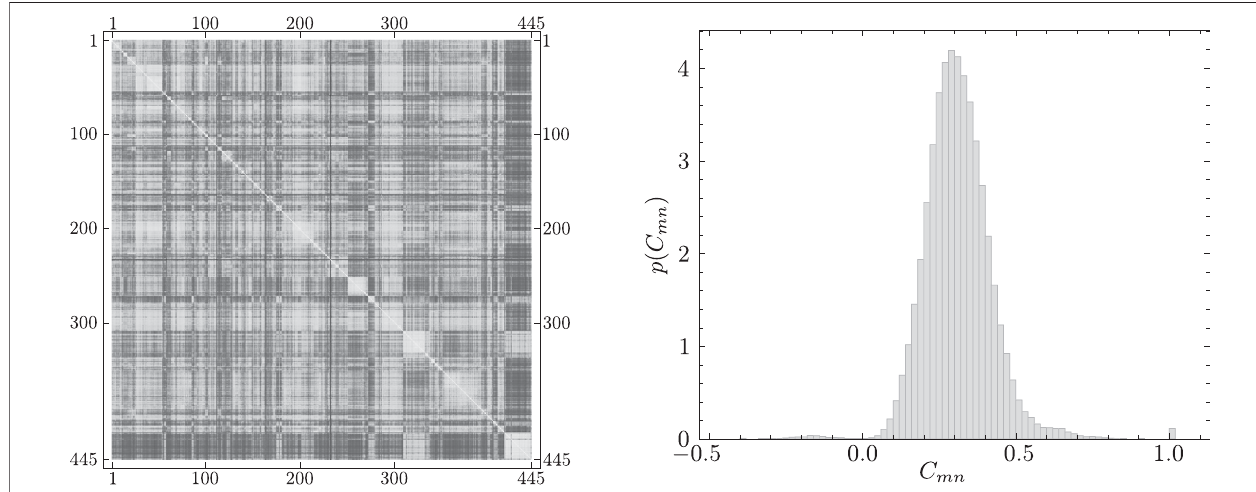
FIGURE 1 | (Left) Visualization of the equal-time cross-correlation matrix for the data for 445 assets from S&P 500 from 2010 to 2019 (2,510 business days). The shade is proportional to correlation strength, with white color corresponding to C nn (cid:2) 1 and the color becoming dark as the correlation becomes large-magnitude negative. (Right) The distribution p ( C mn ) of components of the equal-time cross-correlation matrix. The components are almost all positive. The right tail of the distribution is thicker than the left